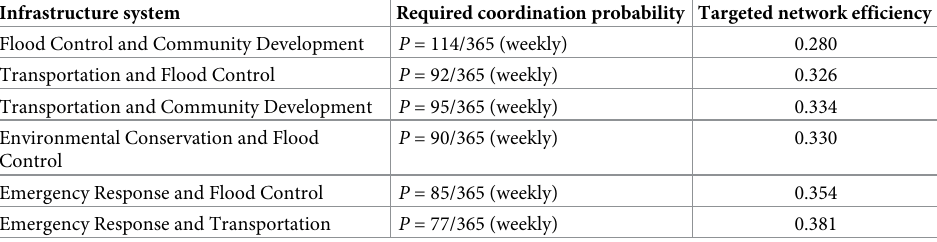
Table 9. Required coordination probability across infrastructure